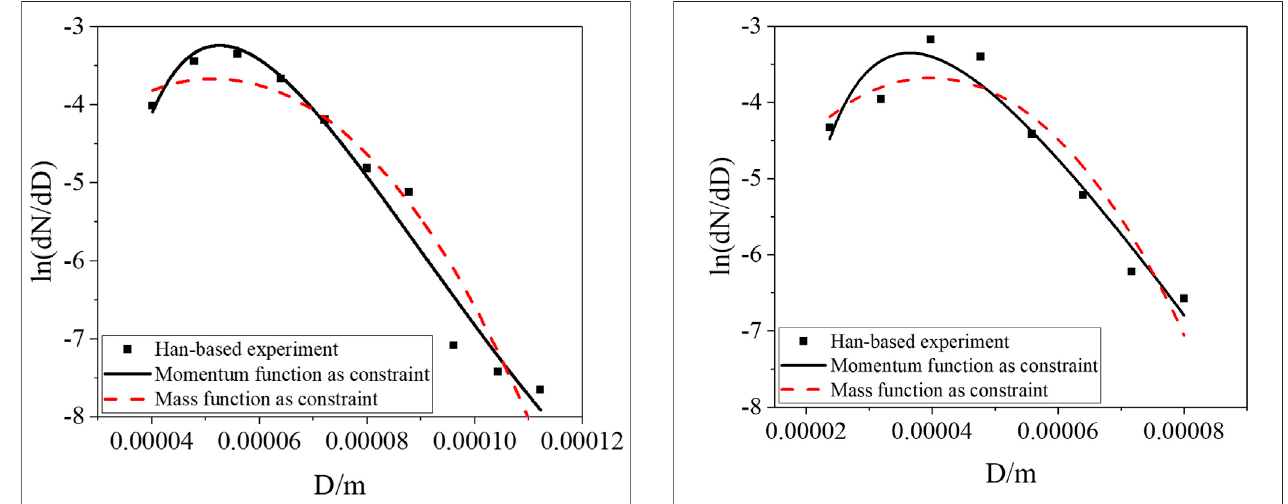
FIGURE 2 | Results of droplet size distribution of HAN-based liquid droplets under the pressure difference of 2.2 MPa.